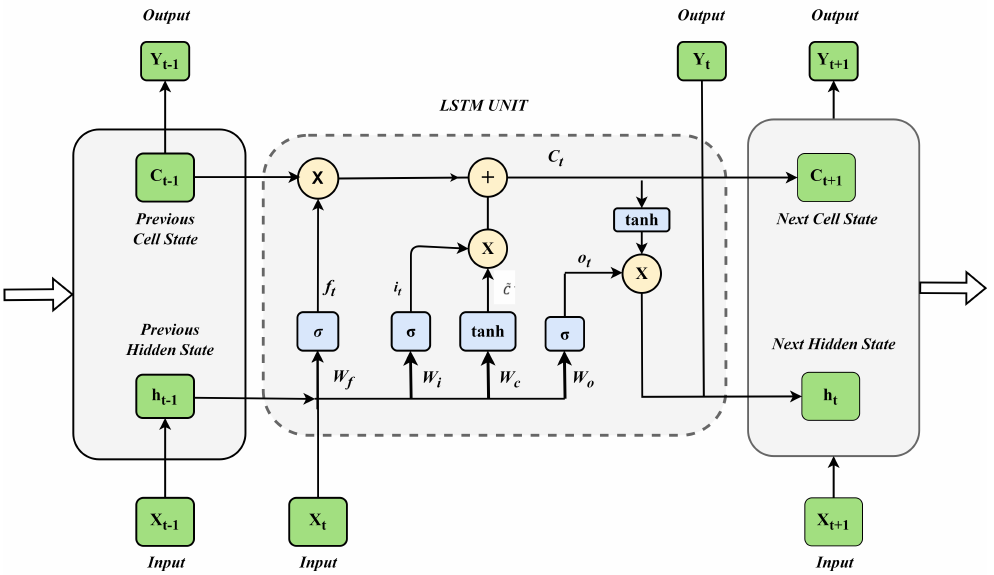
Figure 2. Block diagram of lstm for a single time